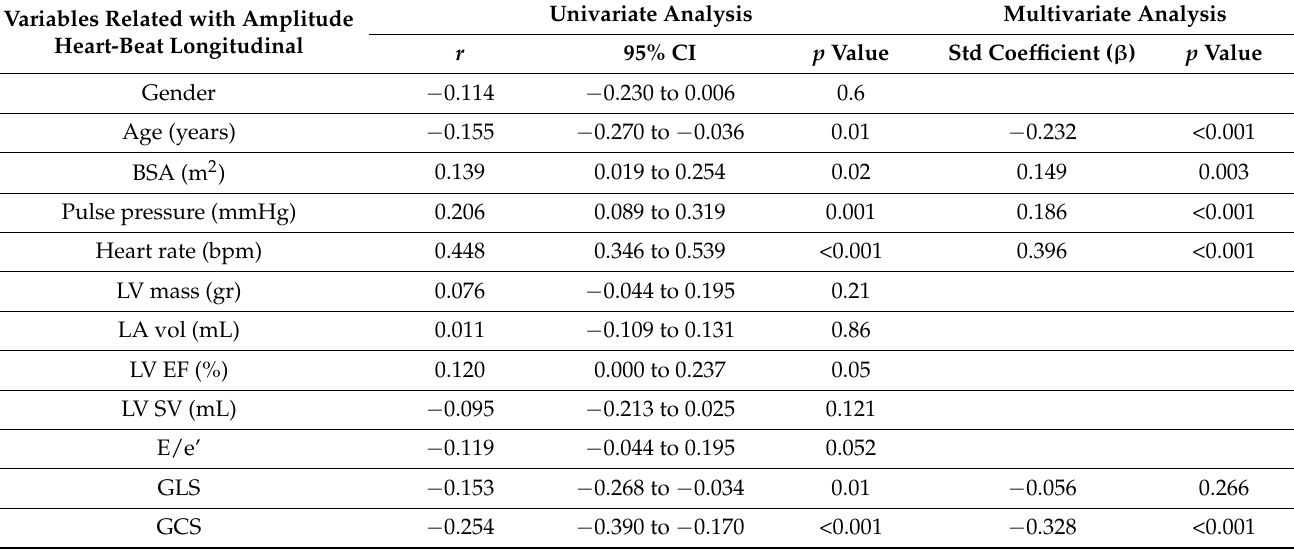
Table 6. Significant independent relation of left ventricular hemodynamic forces in the overall population with clinical and echocardiographic variables by univariate and multivariate analysis. Variables Related with